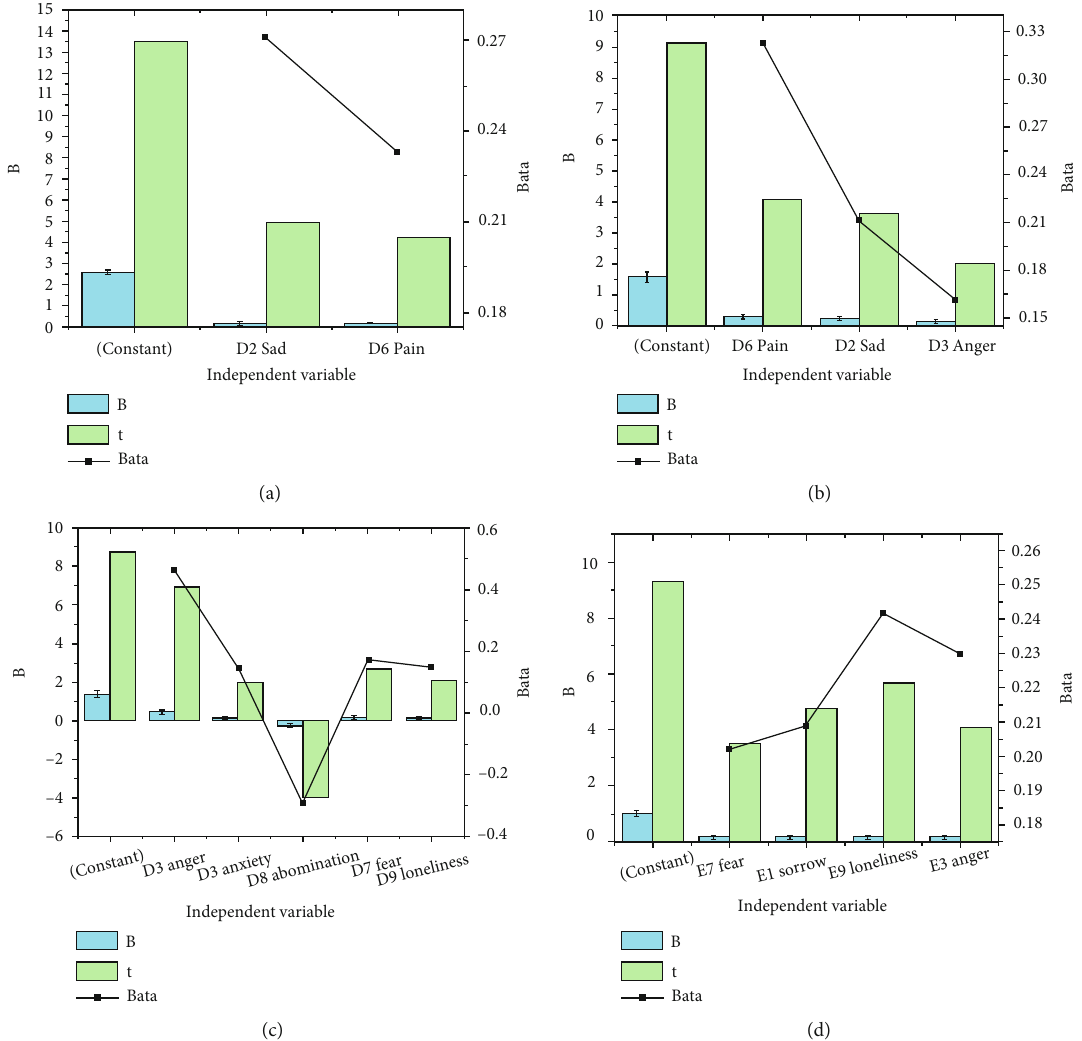
Figure 9: QS results on the alleviation e ff ects of di ff erent music styles on negative emotions around the world ((a) “ Waltz of the Danube ” ; (b) “ Deep Breathing Freely ” ; (c) “ Harry Potter and the Chamber of Secrets ” ; (d) “ Blue Love ” ; B is the nonstandardized coe ffi cient; t represents the emotional